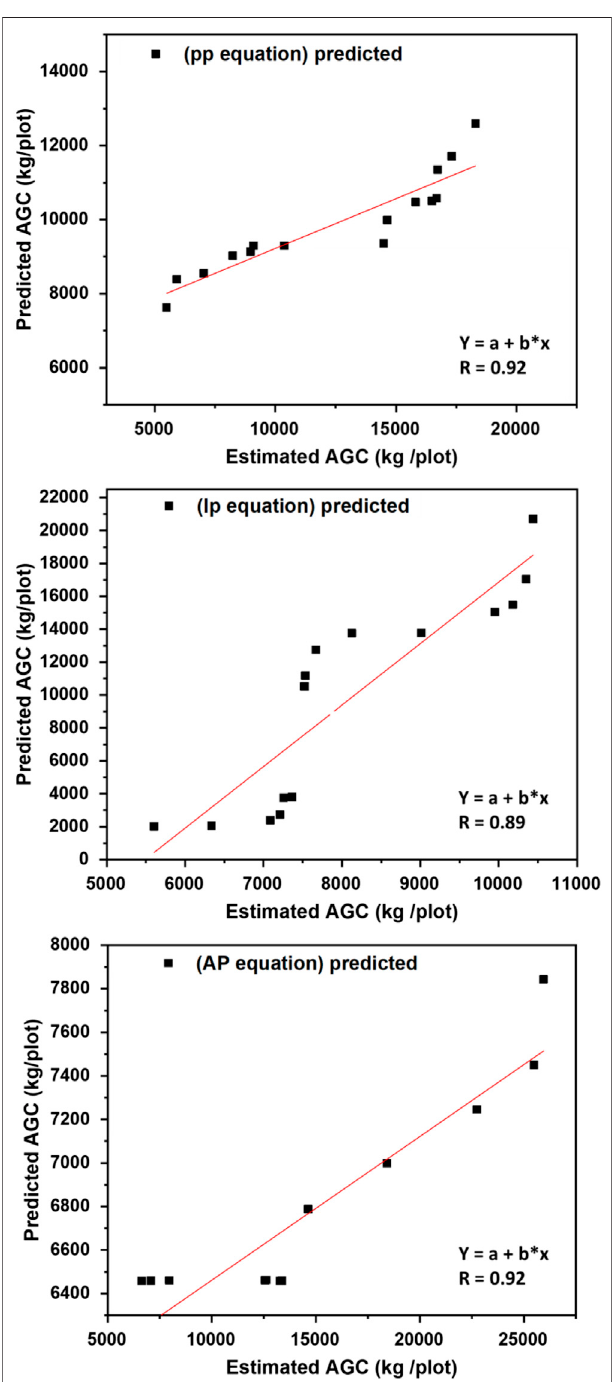
FIGURE 7 | Pearson correlation analysis of the estimated AGC from the fi eld and the predicted values related to NDVI and extracted regression